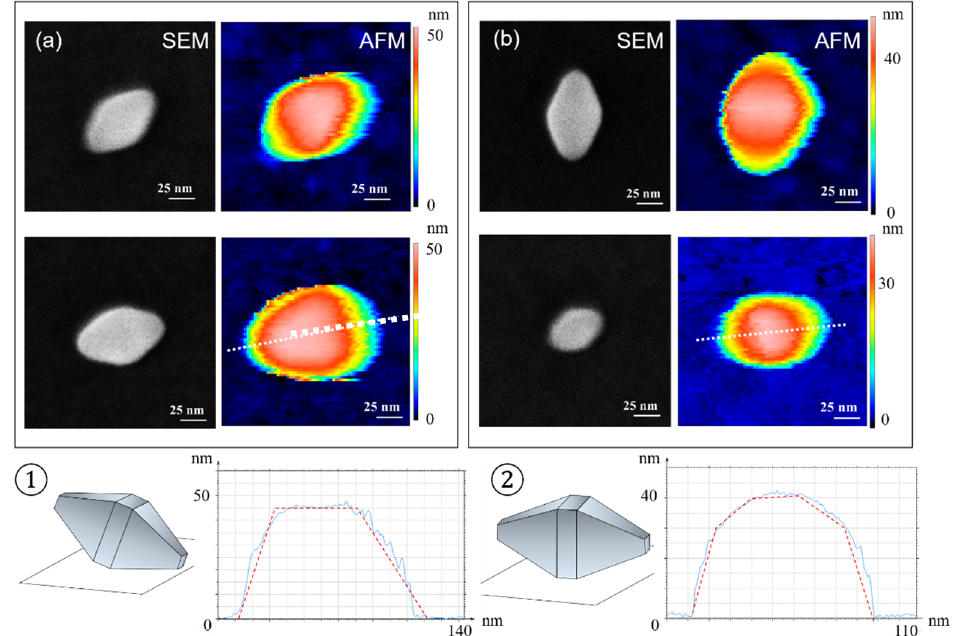
Figure 7. ( a ) AFM (colored) and SEM (black ‐ and ‐ white) image examples of TiO 2 NPs with the orientations ① and ( b ) AFM (colored) and SEM (black ‐ and ‐ white) image examples of TiO 2 NPs with the orientations ② . For each orientation, an AFM profile along the major axis of the TiO 2 NPs (as shown by dotted lines) is displayed at the bottom.